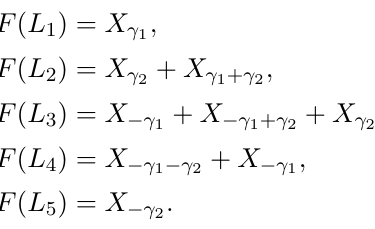
Figure 7. A BPS quiver for ( A 1 ; A 2 ) Argyres-Douglas